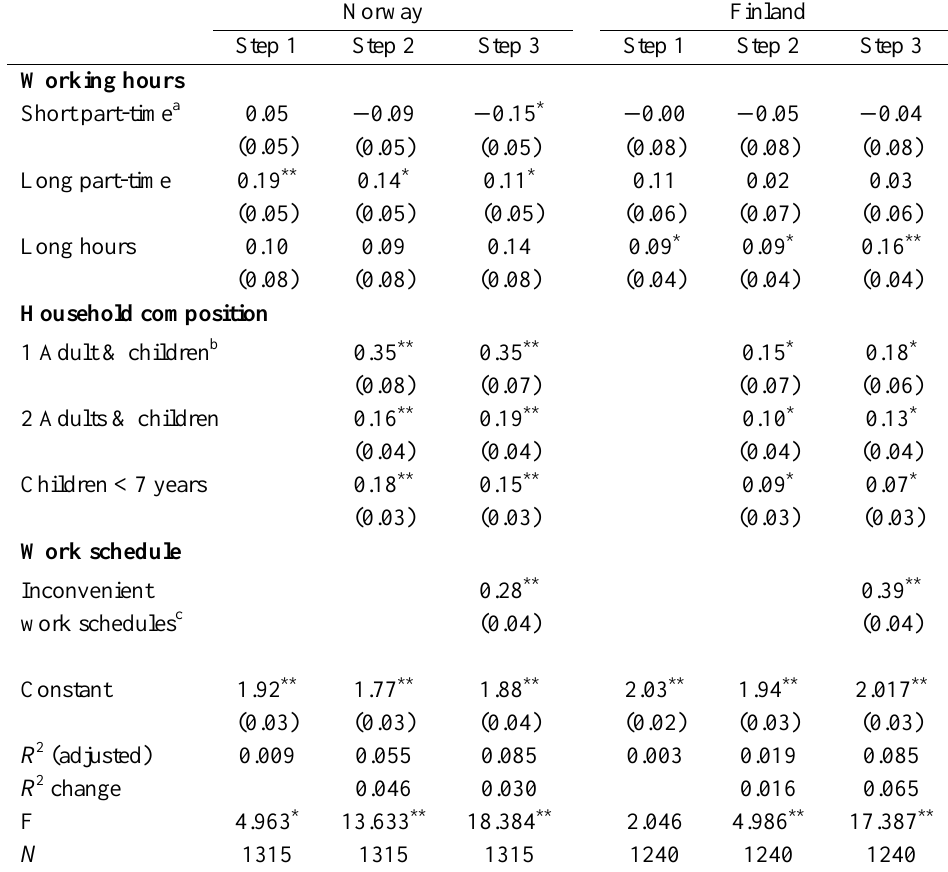
Linear Regression Analyses of Work–Family Interference for Registered Hospital Nurses in Finland and Norway (Women Living With Family). Beta Coefficients and Standard Error. Norway Finland Step 1 Step 2 Step 3 Step 1 Step 2 Step